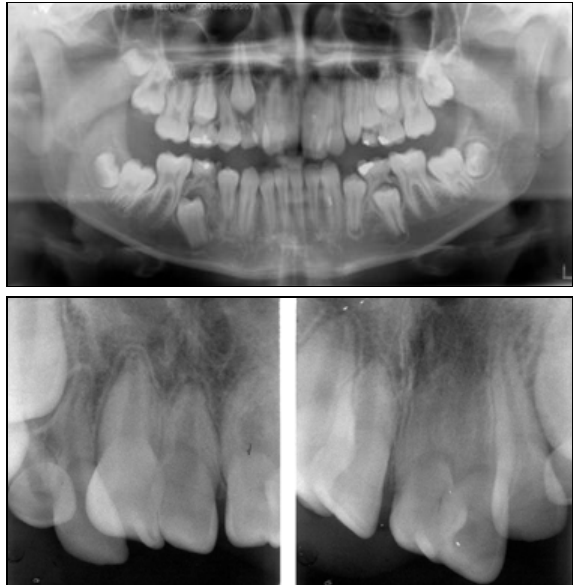
Figure 3,4. The initial panoramic and periapical radiographs. Both incisors had two separate roots, each with one distinct canal system, geminated at least up to their middle